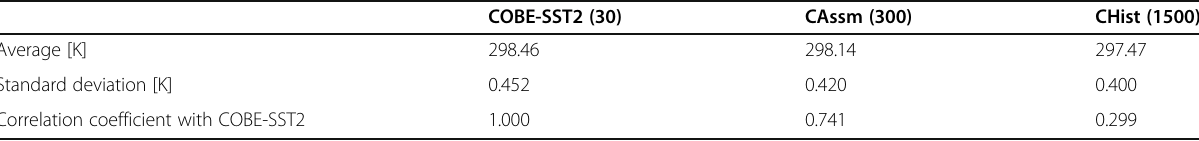
Table 1 Averages and standard deviations of SST JP for August 1981 to 2010 and correlation coefficients of SST JP with COBE-SST2 for August over the 30 years. Numbers in parentheses represent the number of samples for the 30